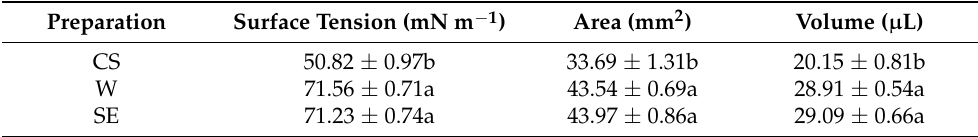
Table 5. Physical properties of the biostimulant from L. usitatissimum seeds.